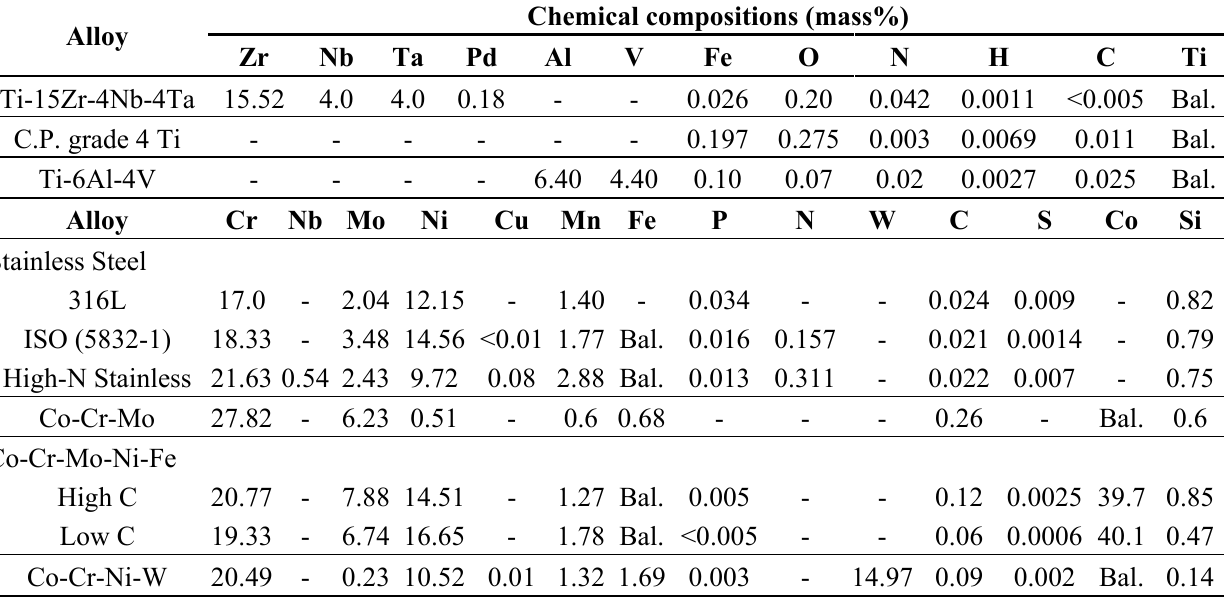
Table 1. Chemical compositions (mass%) of materials